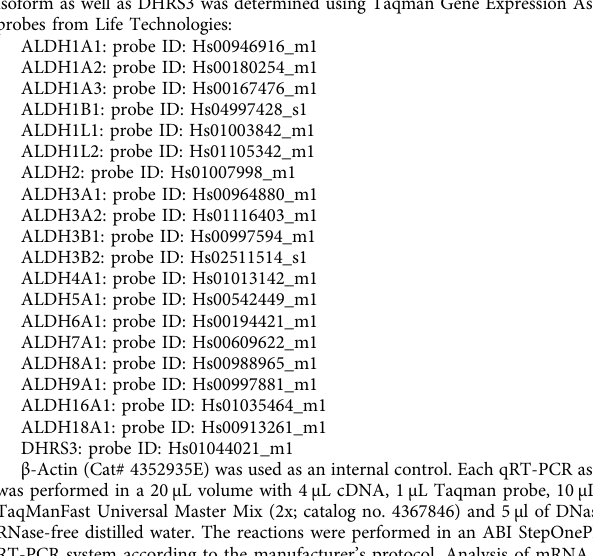
Fig. 9 MCI-INI-3 inhibits ALDH activity and affects RA synthesis in cells. a Inhibition of ALDH activity in U87MG cells by MCI-INI-3 with different concentrations measured with the Alde fl uor assay and plotted as the percentage of ALDH1 + cells. b Inhibition of ALDH activity in U87MG cells by MCI- INI-3 (15 µ M) at different time points measured with the Alde fl uor assay and plotted as the percentage of ALDH1 + cells. c U87MG cells were sorted using Alde fl uor-FACS to enrich the ALDH high population to 75%. The enriched cells were then treated with MCI-INI-3 (10 μ M) for 15 min. The ALDH activity was assayed by the Alde fl uor assay and plotted as the percentage of ALDH1 + cells. d The ALDH activity of GSC-326 cells was analyzed using the Alde fl uor assay without treatment and plotted as the percentage of ALDH1 + cells. DEAB was used as the negative control. e After a 6-day treatment with MCI-INI-3 (15 µ M) or DMSO, the ALDH activity of GSC-326 cells were analyzed using the Alde fl uor assay and plotted as the percentage of ALDH1 + cells. DEAB was used as the negative control. DMSO or MCI-INI-3 (15 µ M) was added at the same time as ROL (10 µ M) ( f , g ) or RAL (5 µ M) ( h , i ) to U87MG cells. After culturing, cells and culture medium were harvested separately, and retinoids were extracted and analyzed by normal phase HPLC. The output of metabolites was compared with the control U87MG cell line, normalized as 1 ( n = 6, technical replicates). DMSO or MCI-INI-3 (15 µ M) was added at the same time as ROL (10 µ M) ( j , k ; n = 6, technical replicates) or RAL (5 µ M) ( l , m ; n = 3, technical replicates) to GSC-83/ALDH1A3-KO.1.2 and control cells (GSC-83). After culturing, cells and culture medium were harvested separately, and retinoids were extracted and analyzed by normal phase HPLC. The output of metabolites was compared with the control GSC-83 cell line, normalized as